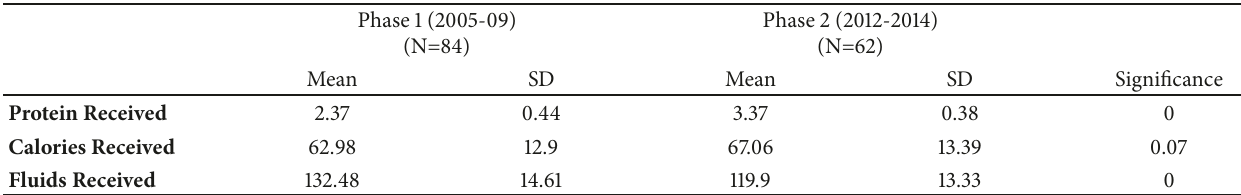
Table 2: Daily nutritional intake before regaining birth